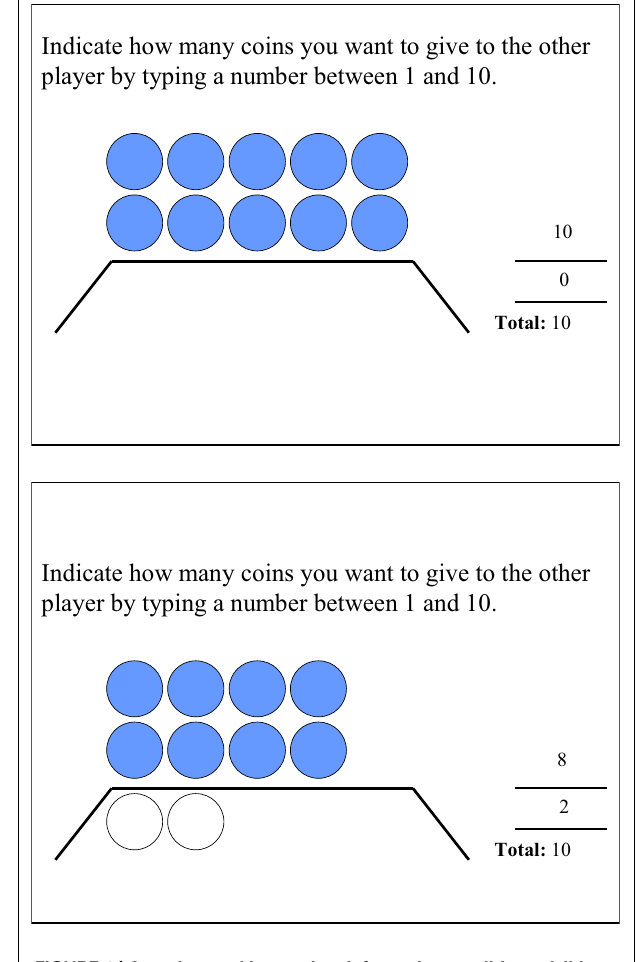
FIGURE 1 | Complete and incomplete information conditions visible to the participant in the role of proposer. The blue coins indicate visibility to both proposer and responder.The white coins indicate a hidden condition and are only visible to the